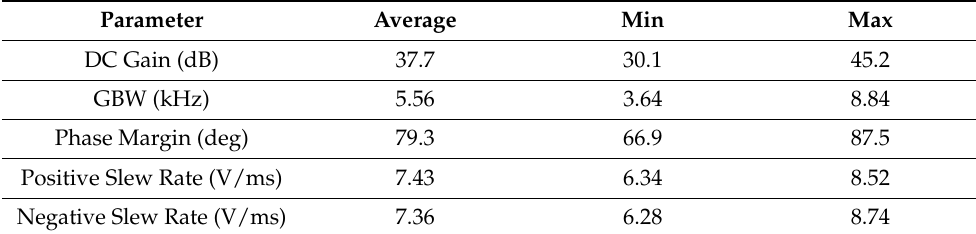
Figure 5. Measured step response in unity gain configuration for different capacitive loads. Table 2. Average main performance parameters over 10 samples for C L = 150 pF. Parameter